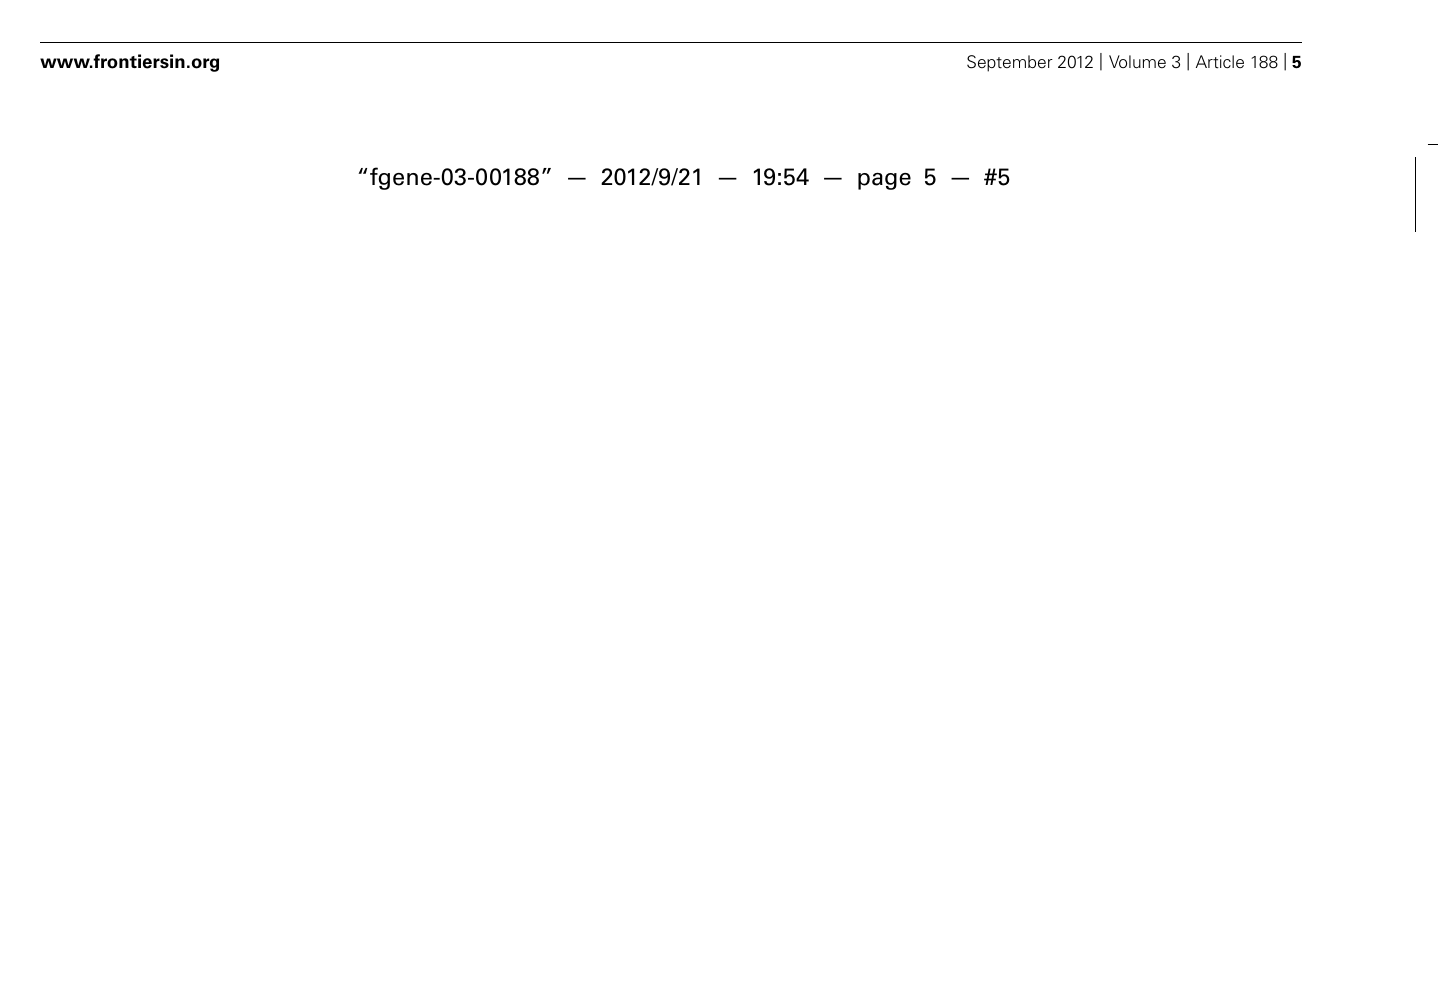
loci in A. thaliana . Right , schematic diagram of theTAD3–RAD52 locus. A. thaliana TER1 andTER2 are encoded on separate chromosomes adjacent to or overlapping these loci. In other Brassicaceae,TAD3 and RAD52 lie on the same chromosome, flanking a single putativeTER gene.The region shown is proportional only for the intergenic space. Arrows indicate predicted transcriptional start